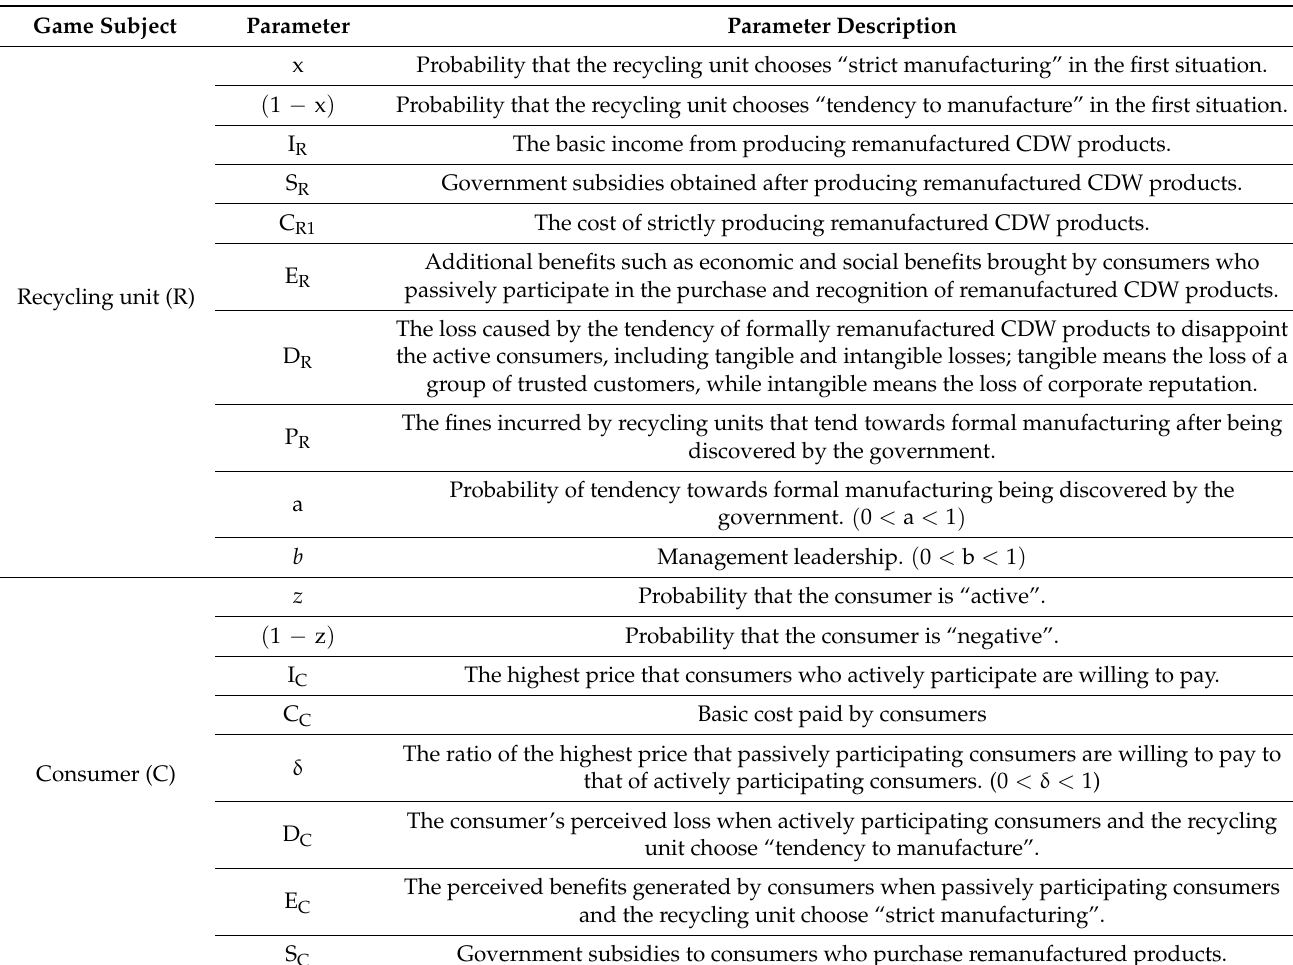
Table 2. Related parameters and description of the main body of the game in the first